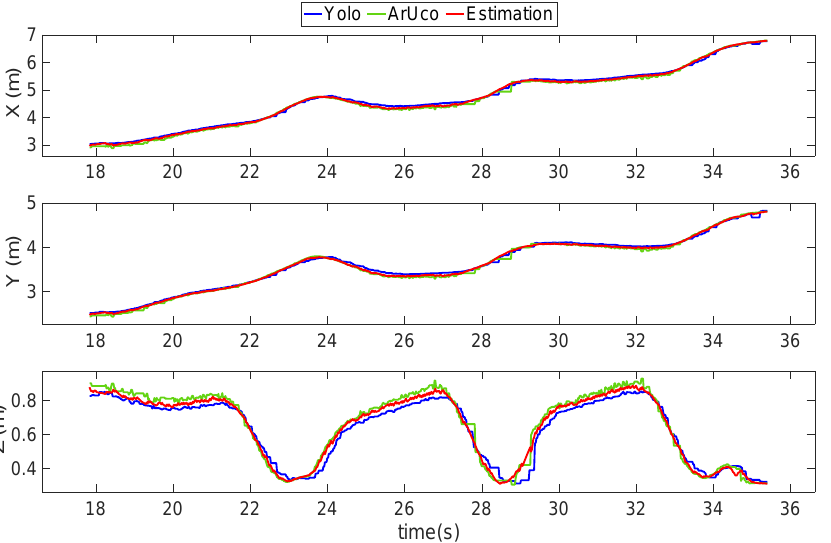
Figure 14. Position estimation results of the UAV landing on a moving platform in an outdoor ex- periment.